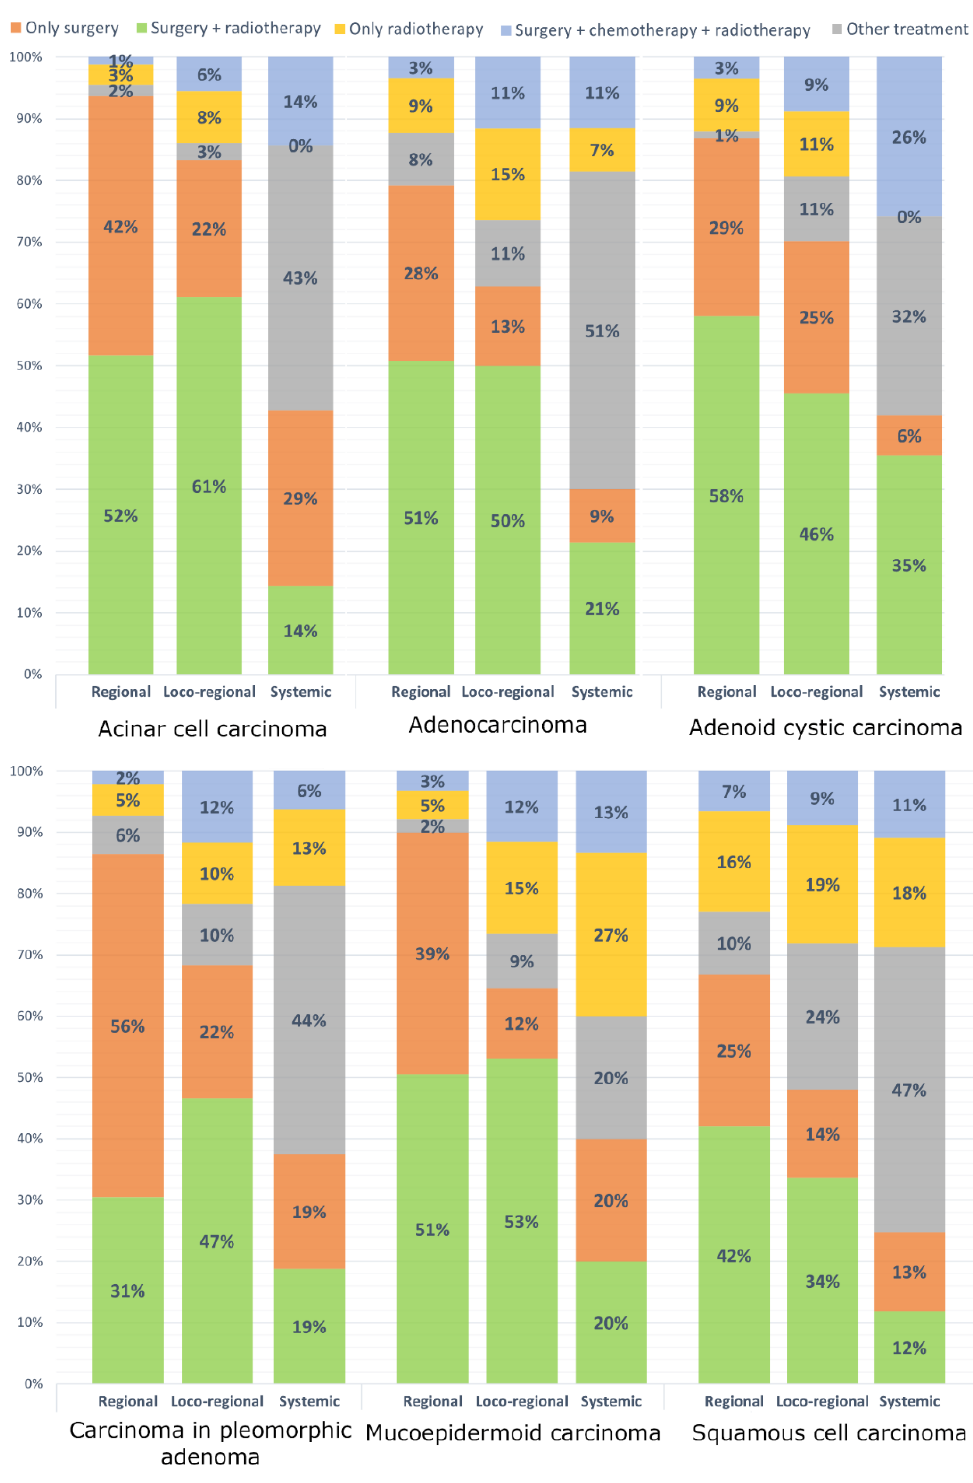
Figure 1. Frequency of treatment modalities stratified by stadium and histology of the cancer.